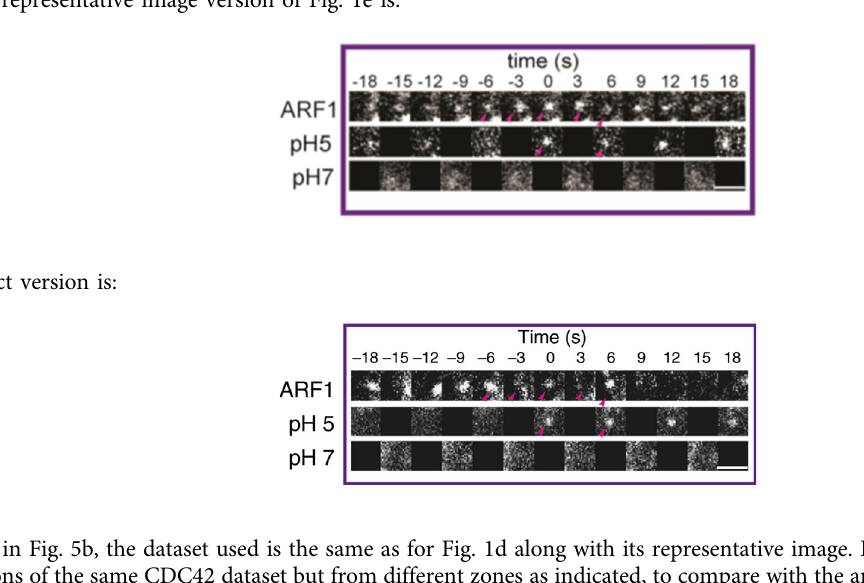
from Fig. 1d, quanti fi cations done using different zones) to the forming SecGFP-GPI endocytic sites and its corresponding random intensity trace to two different regions [circle, black, r = 250 nm; and annulus, orange ( r = 250 – 420 nm)]. Error bars, ( a – b ) represent s.e.m. ( n , Table 1). The random traces were derived from randomly assigned spots of the same radius as the endocytic regions,